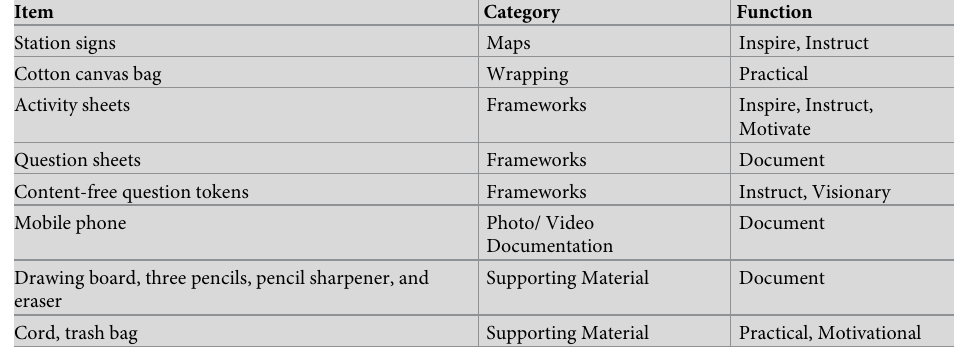
Table 4. Field Guide cultural probe toolkit, according to the categories and functions described by Thoring et al.